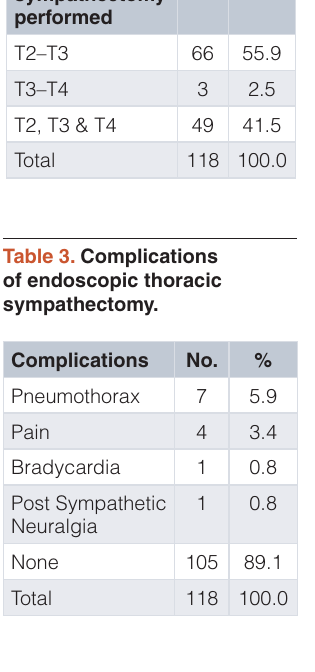
Table 4. Degree of resolution of primary hyperhidrosis in patients post endoscopic thoracic sympathectomy by